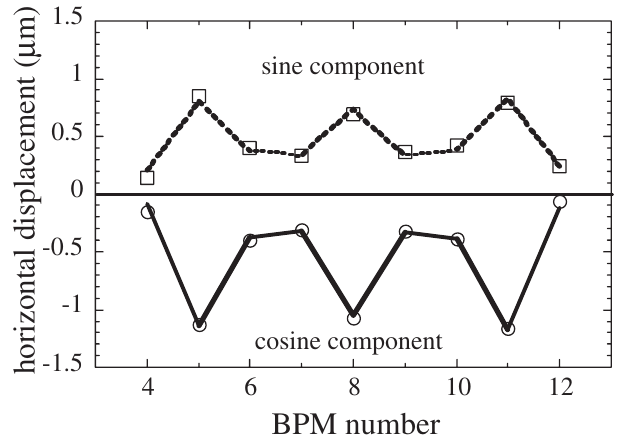
FIG. 2. The cosine and sine components of the horizontal oscillation amplitude at 180 Hz in the eastern arc of the ring. The cosine component is COD at the line trigger timing and the sine component is that after 1 = 720 sec . (on the diagonal phase). The clear circles and squares show measured results. The solid and broken lines are fitted functions assuming that the distortions are due to the two IB families. BPMs 4, 6, 7, 9, 10, and 12 are set in dispersion-free sections of the ring, while BPMs 5, 8, and 11 are in dispersion